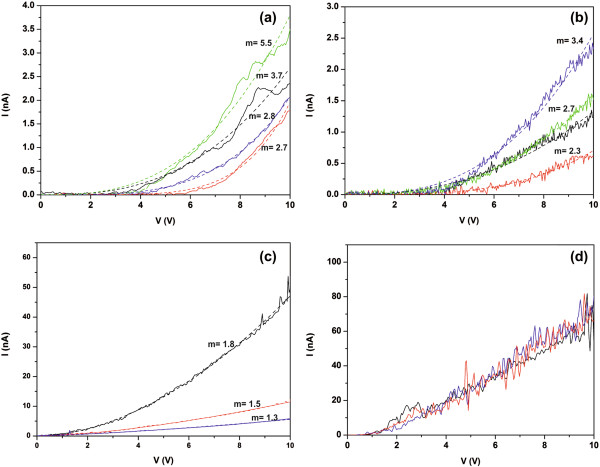
C-AFM measurements of a-TaNx. (a) Positive I-V curves (solid lines) of TaNx deposited on Au for four different points fitted by the space-charge-limited current (SCLC) model (dash lines). (b) Negative I-V curves (solid lines) of TaNx deposited on Au for the same points presented in (a) fitted by the SCLC model (dash lines). (c) Positive I-V curves of TaNx deposited on Si for three different points. The conductive part of the I-Vs exhibits an almost parabolic to almost ohmic behavior (d) Negative I-V curves of TaNx deposited on Si for the points presented in (b). In all I-Vs, the leakage current is quite high, displaying also a very noisy profile.